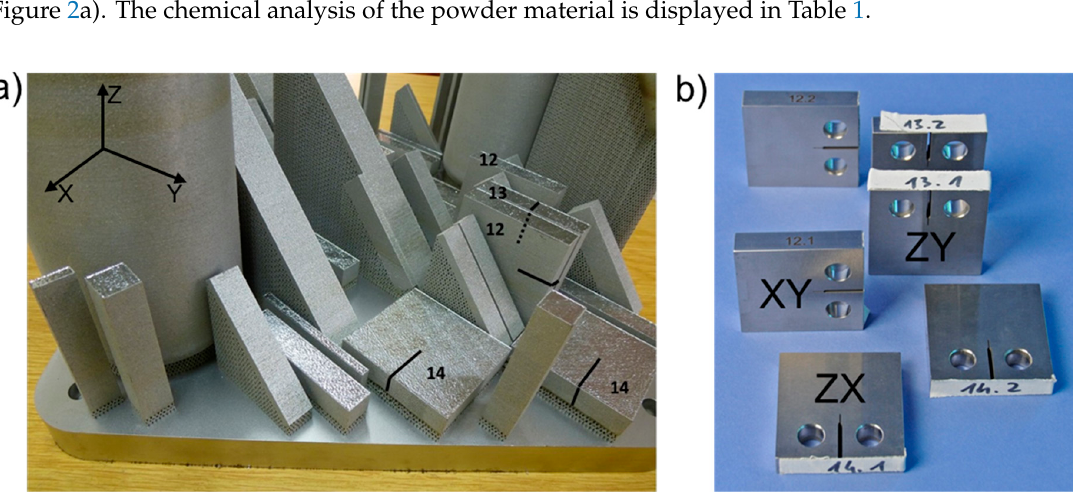
Figure 2. ( a ) Semi-finished LPBF manufactured samples and ( b ) final compact tension specimens after electrical discharge machining (EDM).